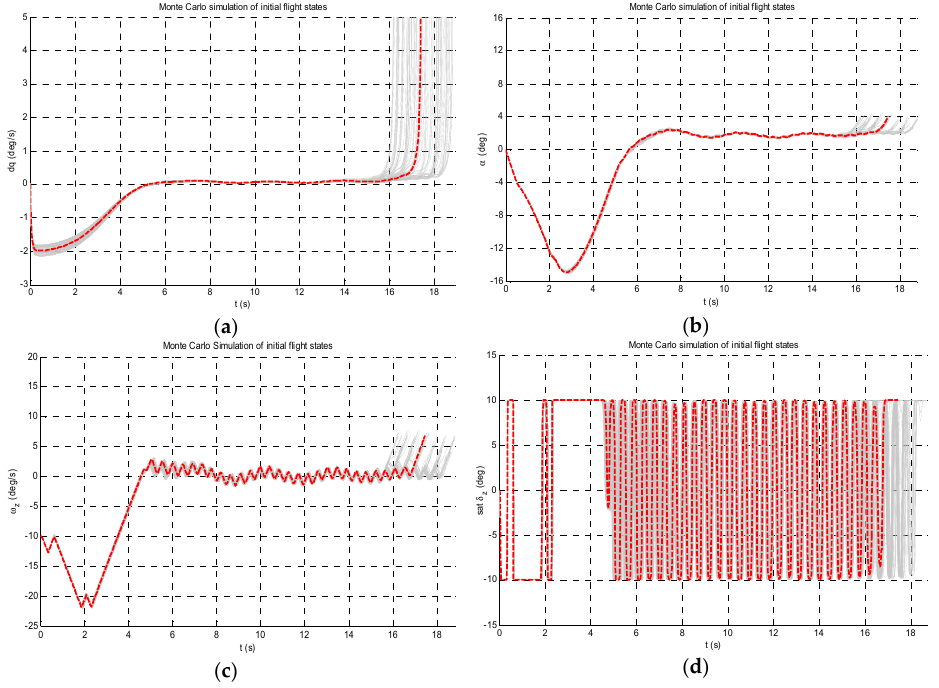
α . q , ( b ) curves of α , ( c ) curves of ω z , , ( c ) curves